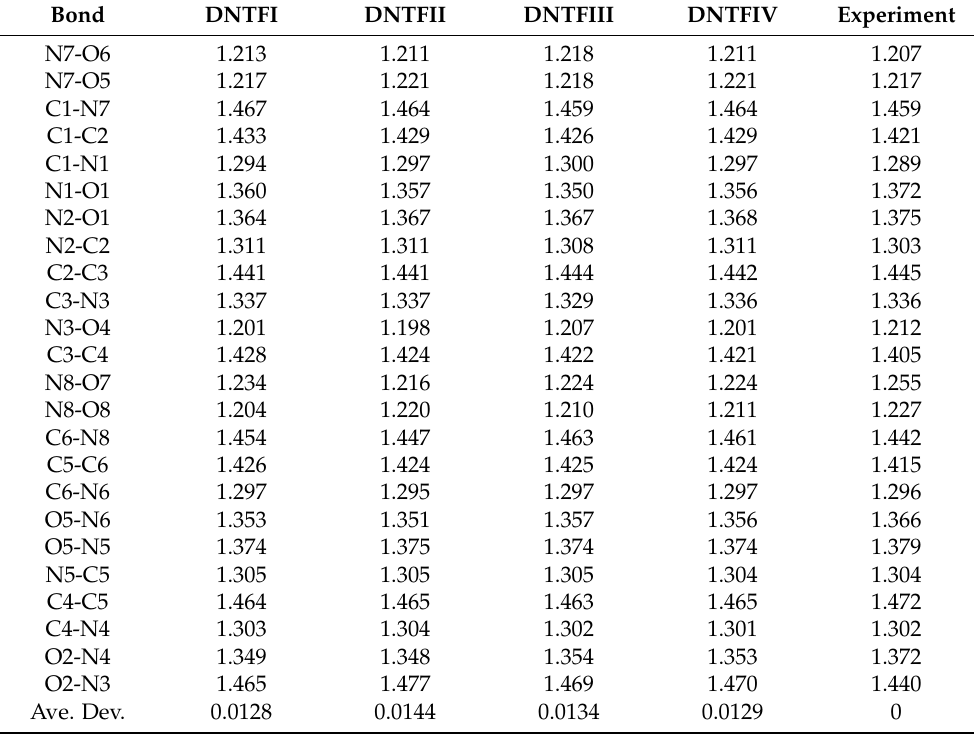
Table 1. Theoretical and experimental bond lengths (Å) of DNTF in the absence of an E-field. Bond DNTFI DNTFII DNTFIII DNTFIV